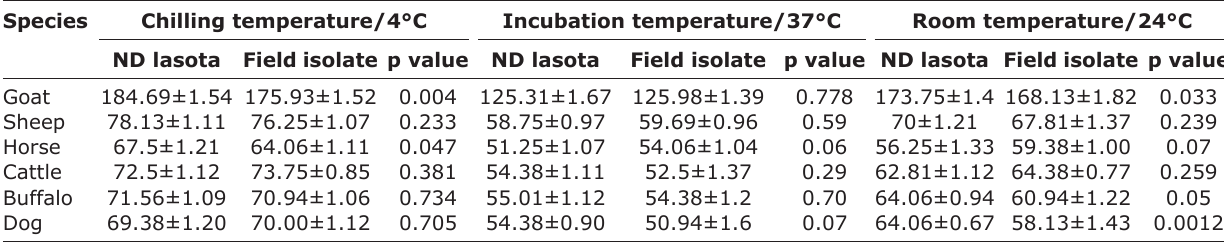
Table-8: Comparing HA of mammalian RBC with two strains of NDV at different temperatures.